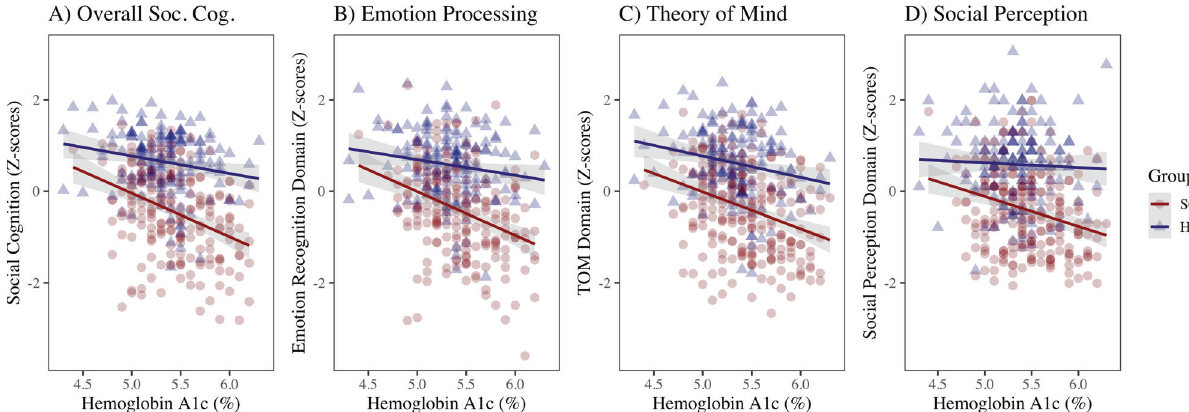
Fig. 3 SSD Group by Hemoglobin A1c Effect on Social Cognition. A Overall Social Cognition, HbA1c ( β = − 0.35, p < 0.001), HC group ( β = − 1.0, p = 0.10), and HC group x HbA1c ( β = 1.5, p = 0.01). B Emotion Processing Domain, HbA1c ( β = − 0.35, p < 0.001), HC group ( β = − 1.2, p = 0.07), and HC group x HbA1c ( β = 1.6, p = 0.01). C Theory of Mind Domain, HbA1c ( β = − 0.30, p < 0.001), HC group ( β = − 0.45, p = 0.47), and HC group x HbA1c ( β = 0.90, p = 0.15). D Social Perception Domain, HbA1c ( β = − 0.24, p < 0.001), HC group ( β = − 0.99, p = 0.12), and HC group x HbA1c ( β = 1.45, p = 0.02). Standardized β coef fi cients are